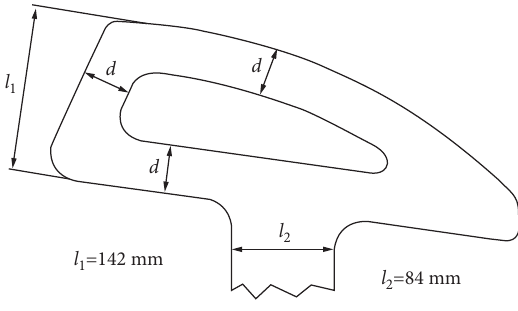
Figure 18: The blade with a hole. Table 5: The single-factor comparison scheme.